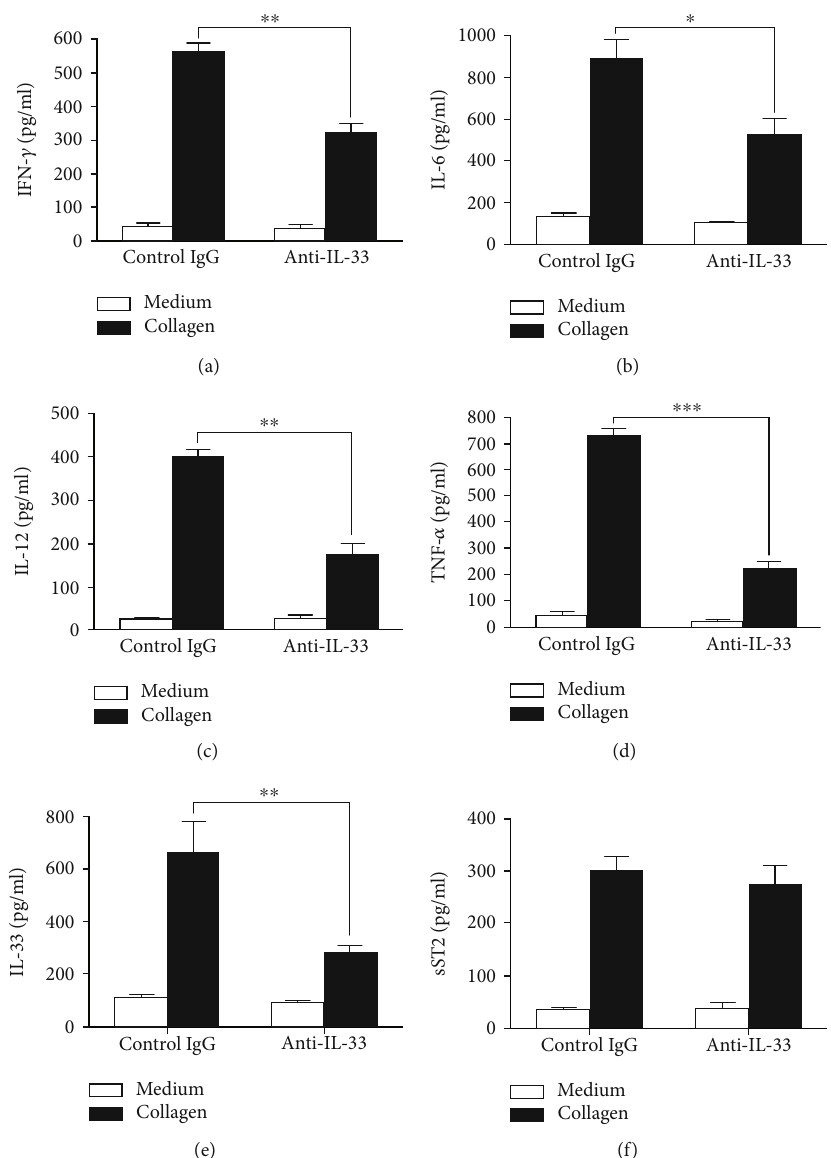
Figure 5: Anti-IL-33 decreases CII-speci fi c proin fl ammatory cytokine production. Splenocytes ( n = 5 ) were prepared from mice on day 43 and cultured with CII for 96h. The content of cytokines in supernatants (72 h for IL-6, IL-12, IL-33, sST2, and TNF- α ; 96h for IFN- γ and IL-10) was detected by ELISA. Compared with the control group, the production of IFN- γ (a), IL-6 (b), IL-12 (c), TNF- α (d), and IL-33 (e) in spleen cell cultures of mice with anti-IL-33 treatment was signi fi cantly inhibited. There was no signi fi cant di ff erence in the content of sST2 in spleen cells between the two groups (f). Data are mean ± SEM of triplicate cultures; n = 5 . ∗ p < 0 : 05 , ∗∗ p < 0 : 01 , and ∗∗∗ p < 0 : 001 by two-way ANOVA with Bonferroni ’ s multiple comparison